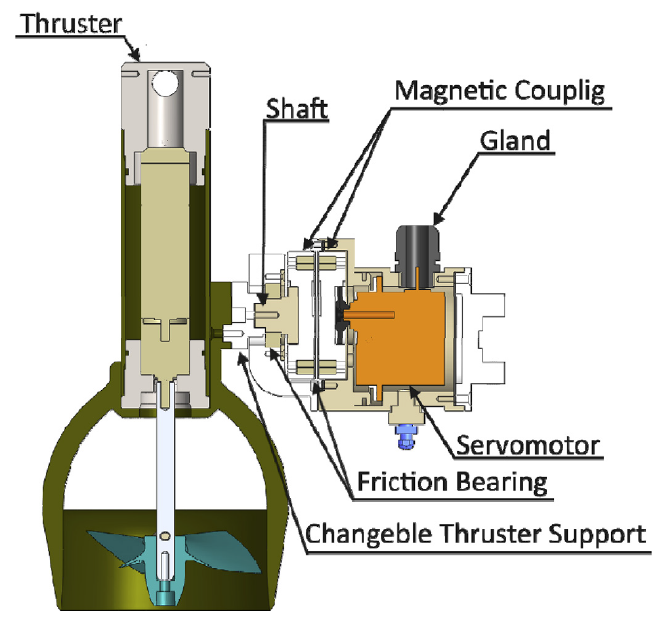
Figure 17. 2-DOF reconfigurable magnetic coupling thruster [61].